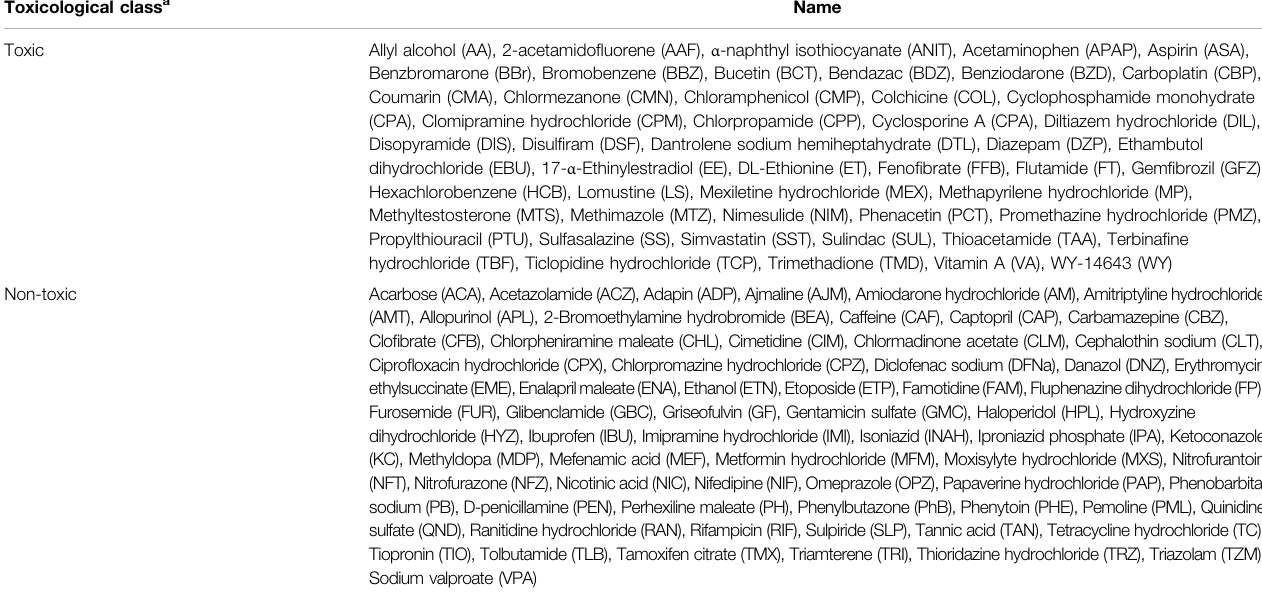
TABLE 1 | List of chemical substances used in the present study and their toxicological classes. Toxicological class